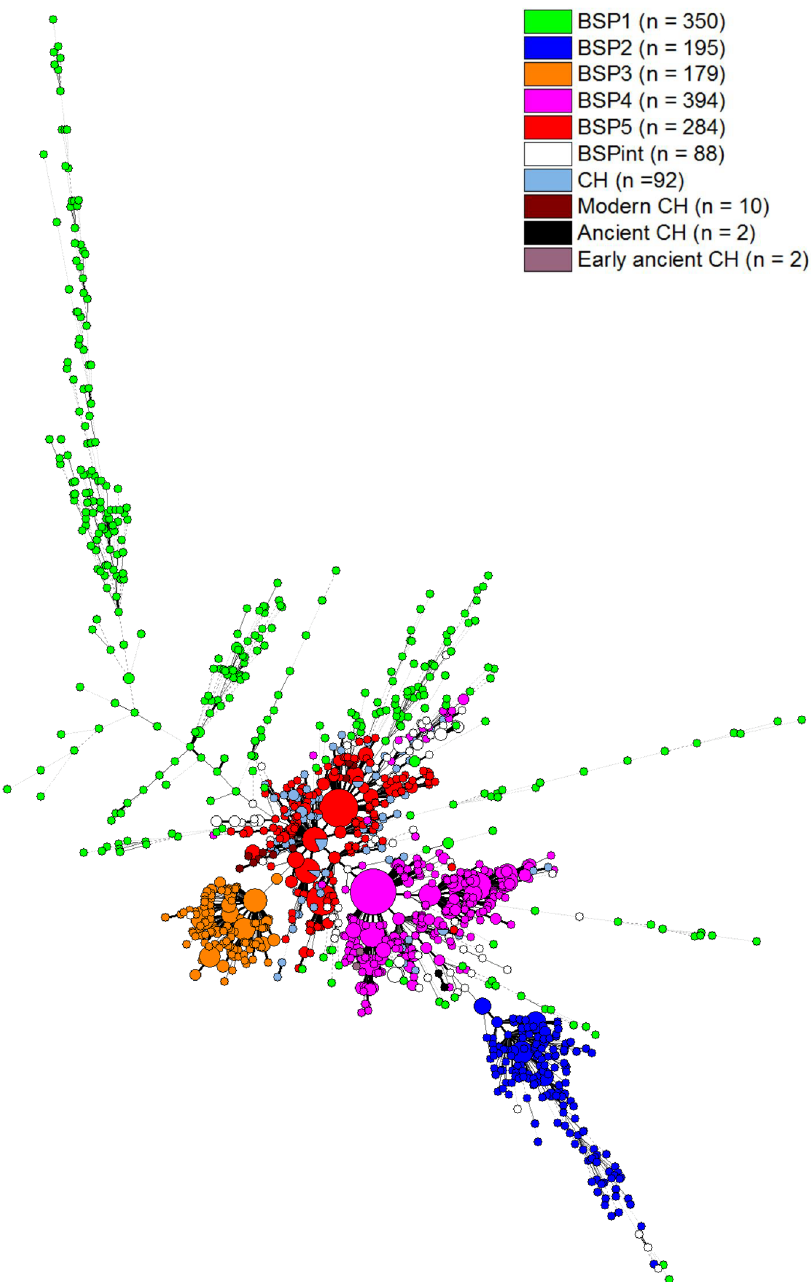
Figure 4. A minimum spanning tree (MST) illustrating evolutionary relationships of cases of clonal heterogeneity observed among Beijing isolates from China versus BSP groupings (n = 1596 strains). The MST was constructed based on 24-loci MIRU-VNTRs on a total of 1490 strains representing different BSP clonal complexes (BSP1 n = 350, BSP2 n = 195, BSP3 n = 179, BSP4 n = 394, BSP5 n = 284, BSPint n = 88), and 106 entries for the group “clonal heterogeneity” representing 53 isolates. Among the latter, 46/53 strains were from our dataset while 7/53 strains were from a recent study by Yin et al . 20 , and described as Modern (10 entries from 5 strains), Ancient (2 entries from 1 strain), and Early ancient (2 entries from 1